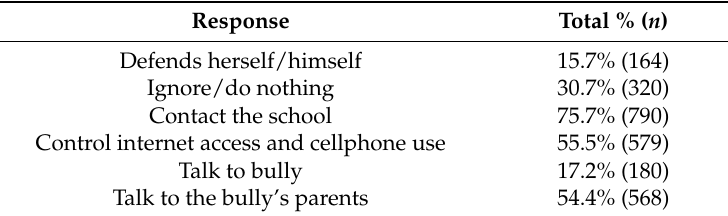
Table 3. Parents’ responses to bullying